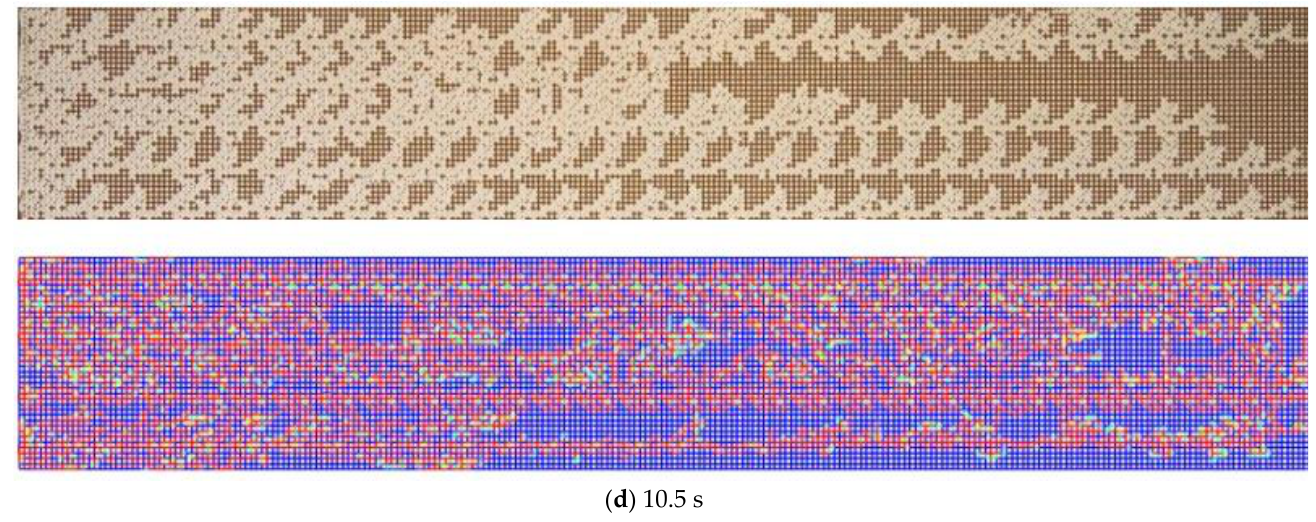
Figure 14. Microchip filling dynamics: comparison of computation (bottom) and experiment (top). Color: blue — oil, red — displaced fluid.